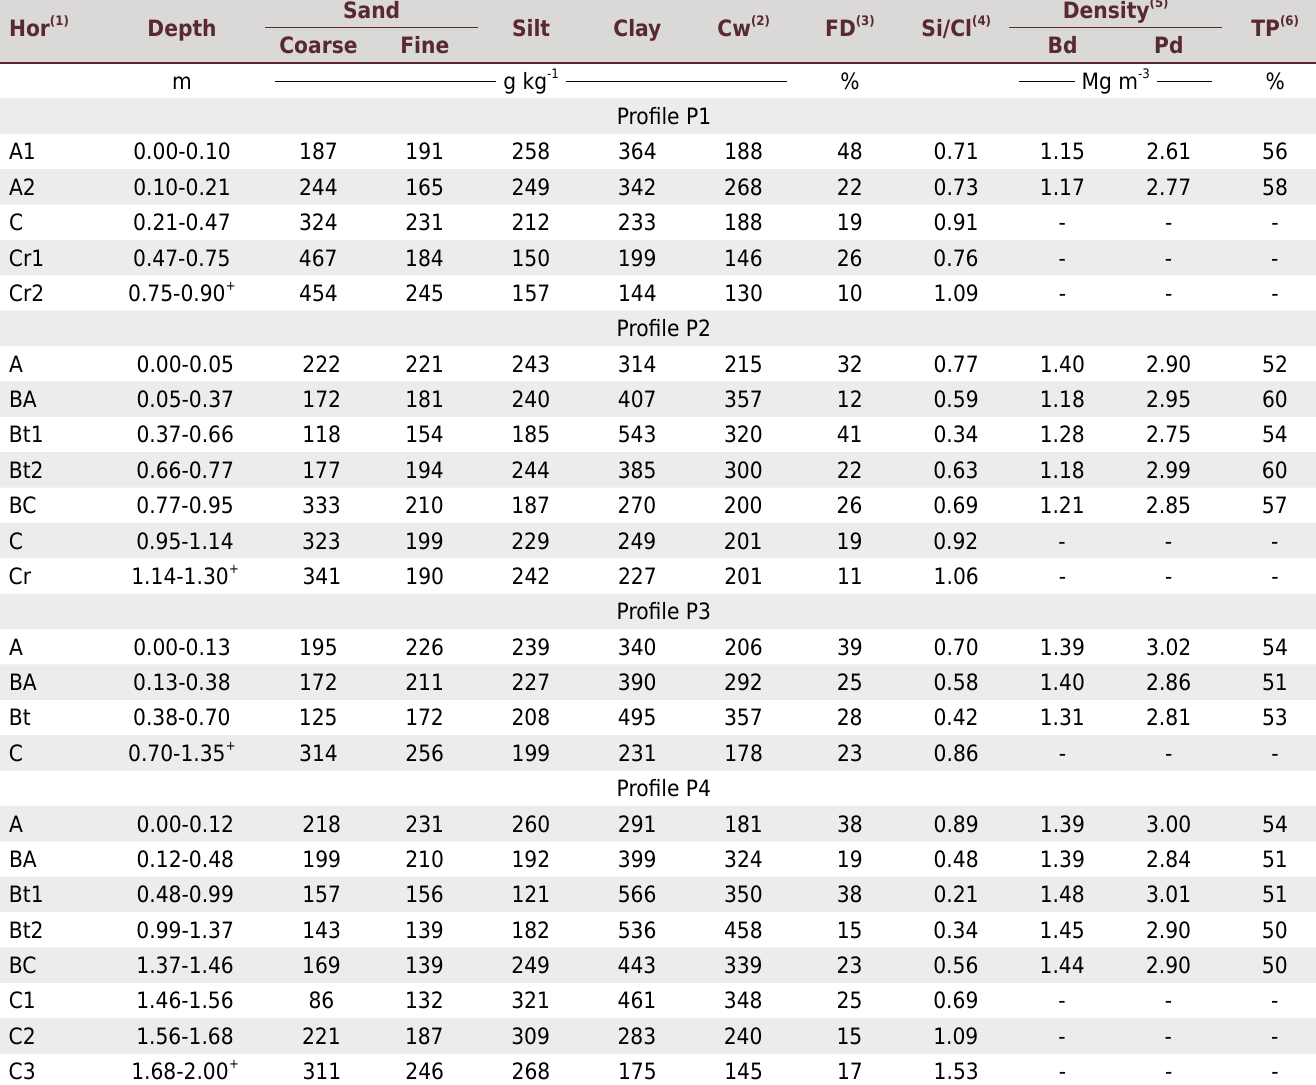
Table 2. Physical attributes of soil profiles in a toposequence in Pinheiral,